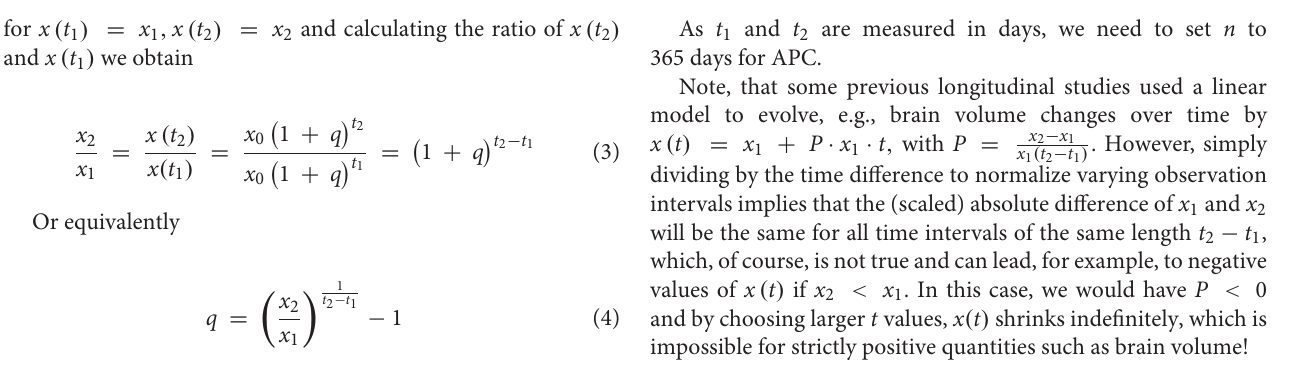
for x ( t 1 ) = x 1 , x ( t 2 ) = x 2 and calculating the ratio of x ( t 2